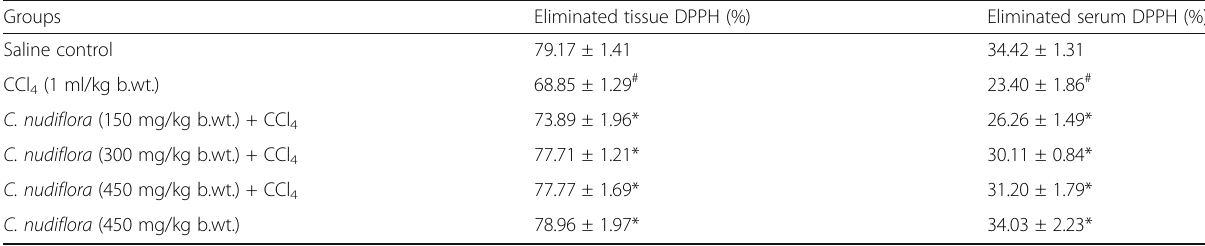
Table 5 Eliminated DPPH in hepatic tissue and serum of rats treated with C. nudiflora at various doses